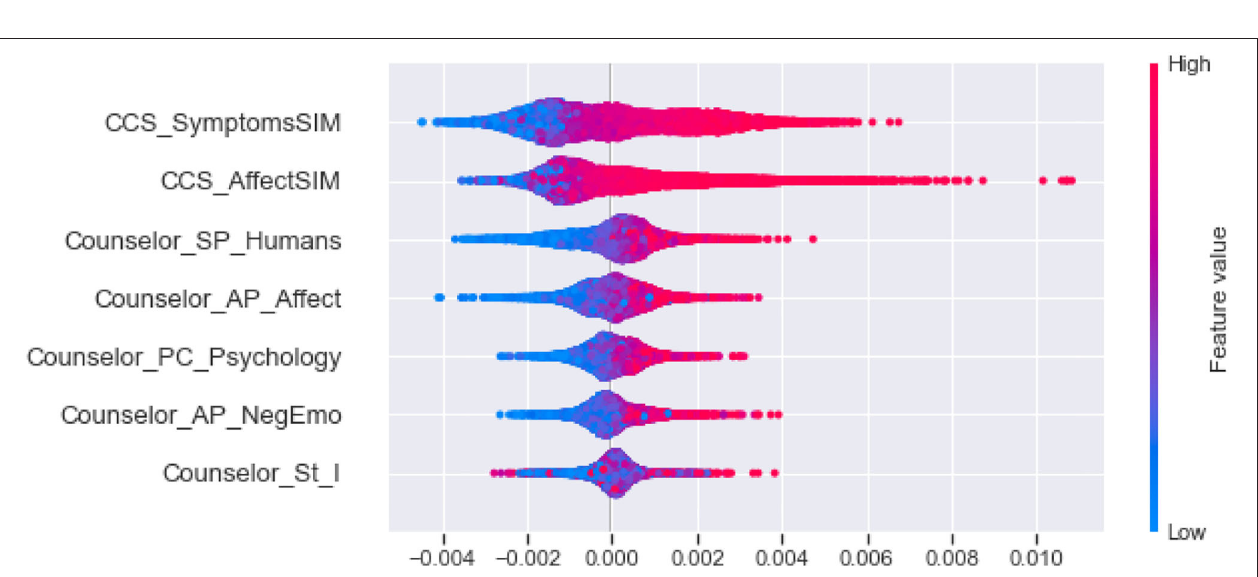
FIGURE 5 | The SHAP summary plots about the adjustment to the predicted in perceive helpfulness numbers (x-axis) for each of the second type